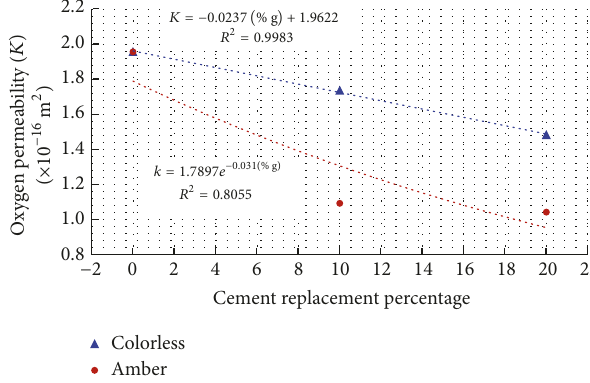
Figure 1: Mortar compressive strength results (average values and standard deviations).